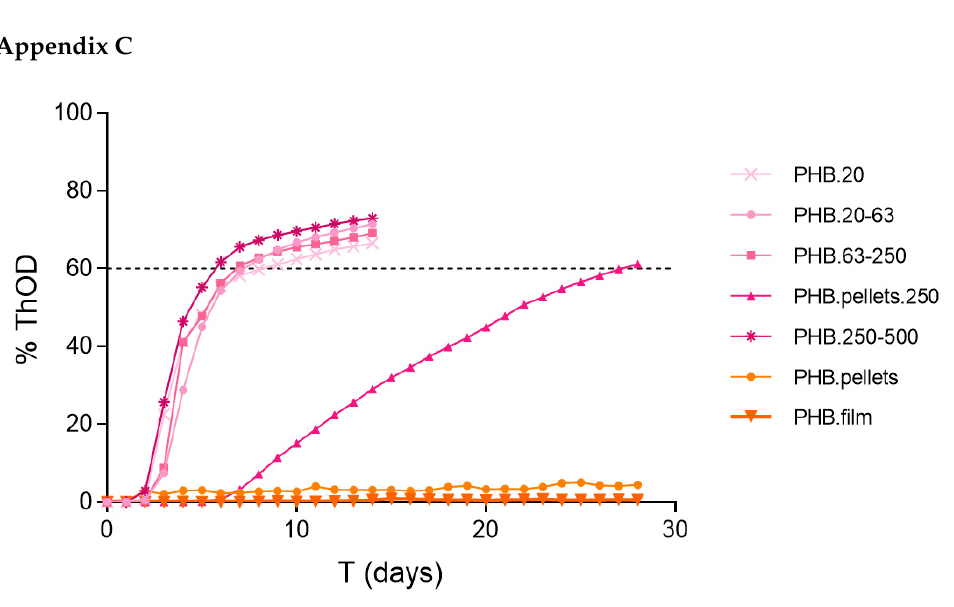
Figure A1. Percentage of biodegradation expressed as % ThOD for PHB particles with size ranges of: ≤ 20 µm, 20–63 µm, 63–250 µm, and 250–500 µm, pellets of 1–3 mm, micronized pellets <250 µm, and 100 µm thick films. Data for PHB pellets and film taken from [11].